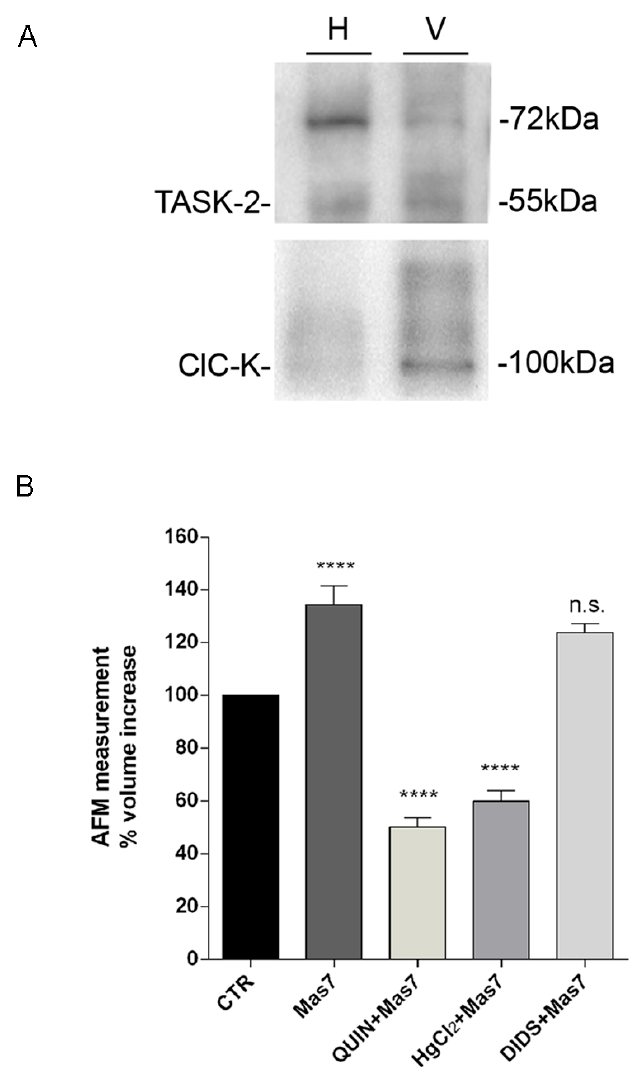
Figure 5. Molecular mechanism of AQP2 vesicle swelling. ( A ) Expression of TASK-2 and ClC-K in AQP2 vesicles. 30 µ g purified AQP2 vesicles from rat inner kidney medulla were blotted and probed with specific anti-TASK-2 and with anti-ClC-K antibodies. Anti-TASK-2 antibodies detected a 55 kDa band along with a 72 kDa bands corresponding to the monomeric and glycosylated forms of the TASK-2 potassium channel respectively whereas anti-ClC-K antibodies stained a band at 100 kDa. ( B ) AQP2 vesicle swelling measured by Atomic Force Microscopy: effect of TASK-2 inhibitor. Means ± S.E.Ms values of % of volume changes measured by AFM with respect to control. Activation of Gi with Mas7 (20 µ M) resulted in a 34% increase in vesicle volume (134.1 ± 7.1%, n = 16, **** p < 0.0001). Preincubation of vesicle with quinidine (0.5 mM) completely abolished Mas7-induced vesicle swelling causing instead a significant reduction in vesicle volume with respect to control (50.2 ± 3.4%, n = 63, **** p < 0.0001). Vesicle preincubation with HgCl 2 (0.3 mM) also prevented Mas7 activated vesicle swelling reducing vesicle volume (59.9 ± 3.9%, n = 45, **** p < 0.0001). DIDS (10 µ M) had no effect on Mas7 induced increase in vesicle volume (123.7 ± 3.3%, n =